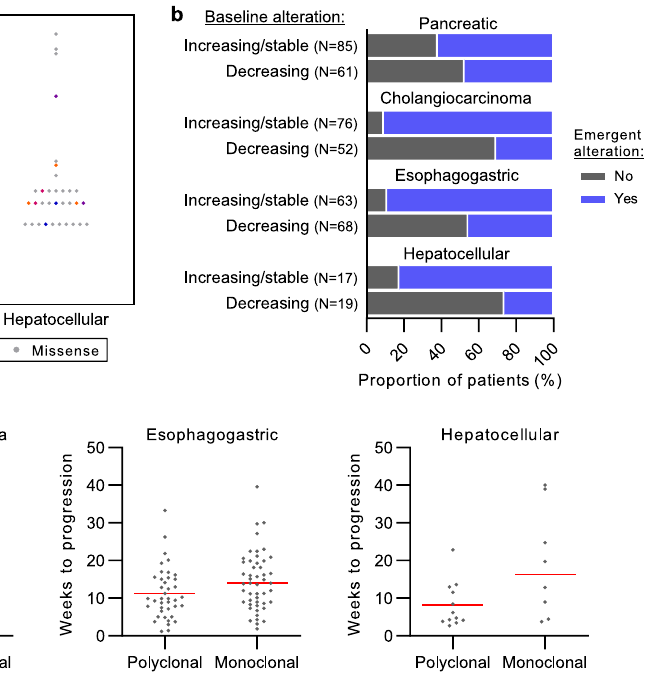
Fig.2|CharacteristicsofemergentctDNAalterations.a VAFofemergentctDNA alterations color-coded by mutation type are show in a dot plot. b Differences in proportions were assessed using the Chi-square test. Emergent ctDNA alterations were more prevalent in patients with increasing or stable maximal VAF in baseline alterations in PDAC ( p =0.04), CCA ( p <0.001), EGC ( p <0.001), and HCC